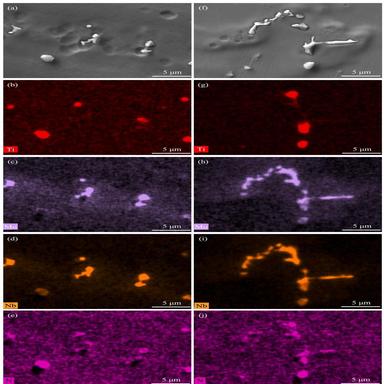
EDX maps analysis of the particles within the WM.